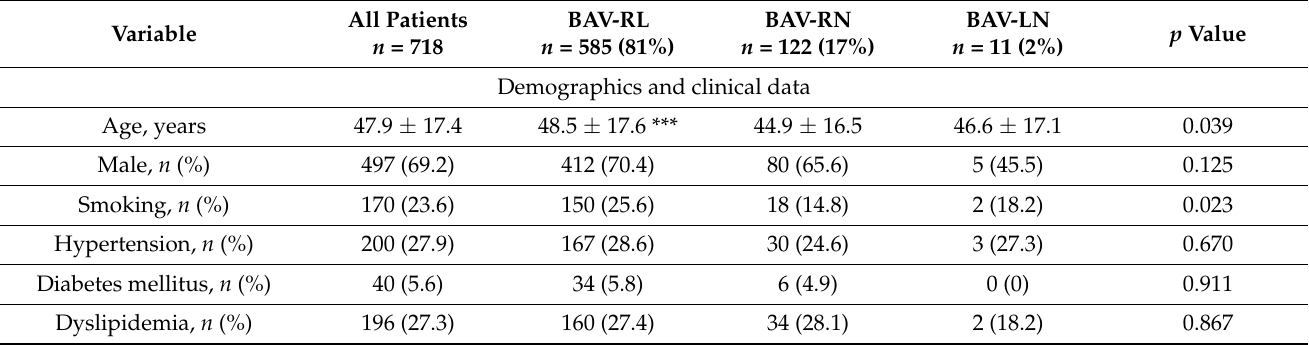
Table 1. Baseline characteristics of study participants according to BAV